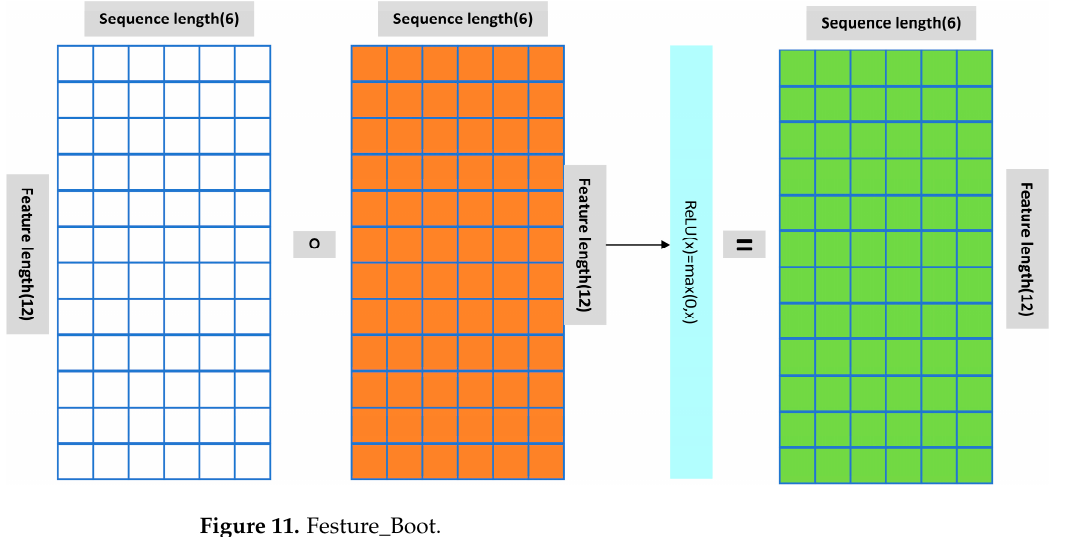
Figure 10. Festure_Convolution.